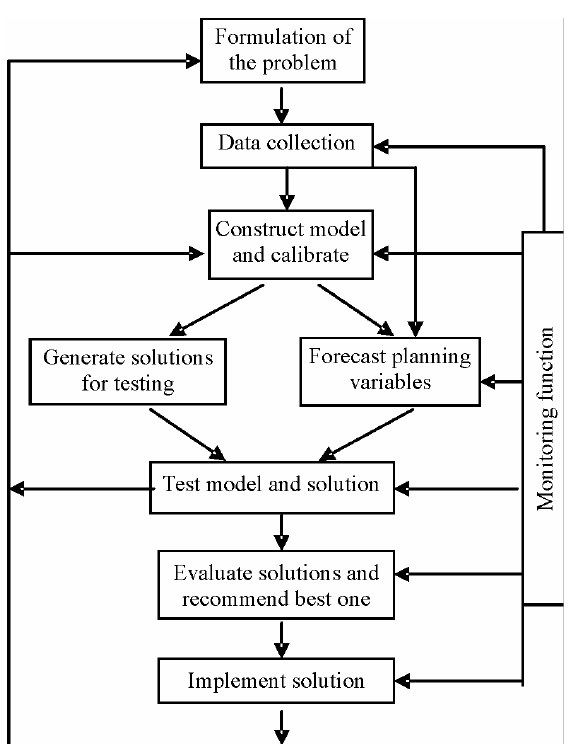
Fig 5. Planning and monitoring with models